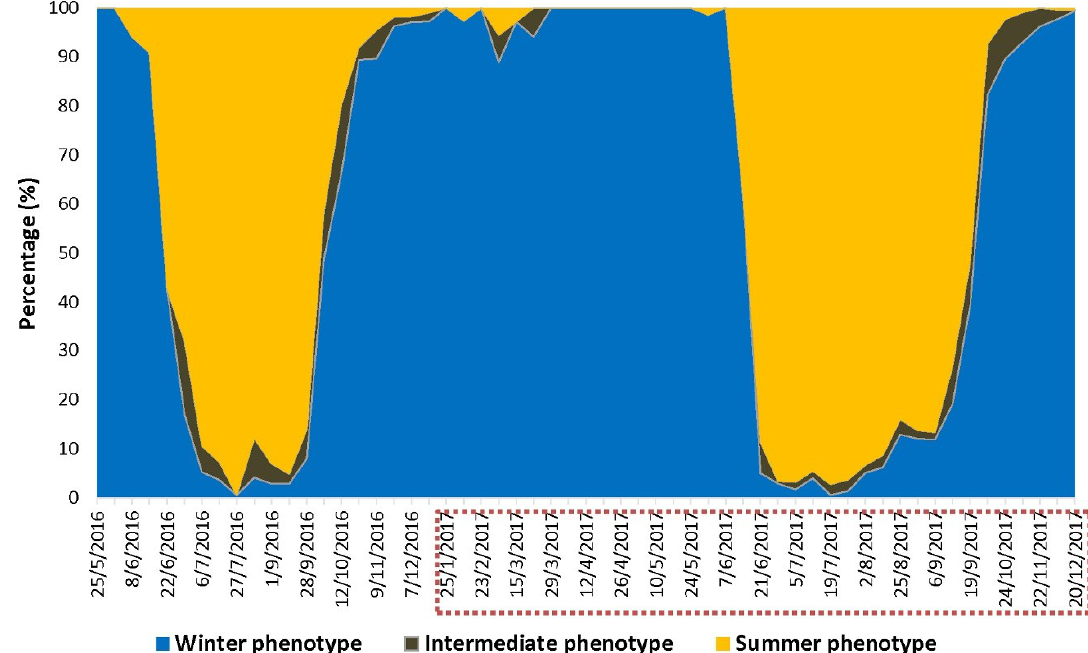
Figure 7. Ratio of phenotypes (summer, winter or intermediate morphs) of field-captured D. suzukii individuals during the sampling period May 2016–December 2017. The red dotted rectangle around some of the dates represents the period during which seasonal reproductive status of D. suzukii females captured in the field was assessed (see Figure 6).